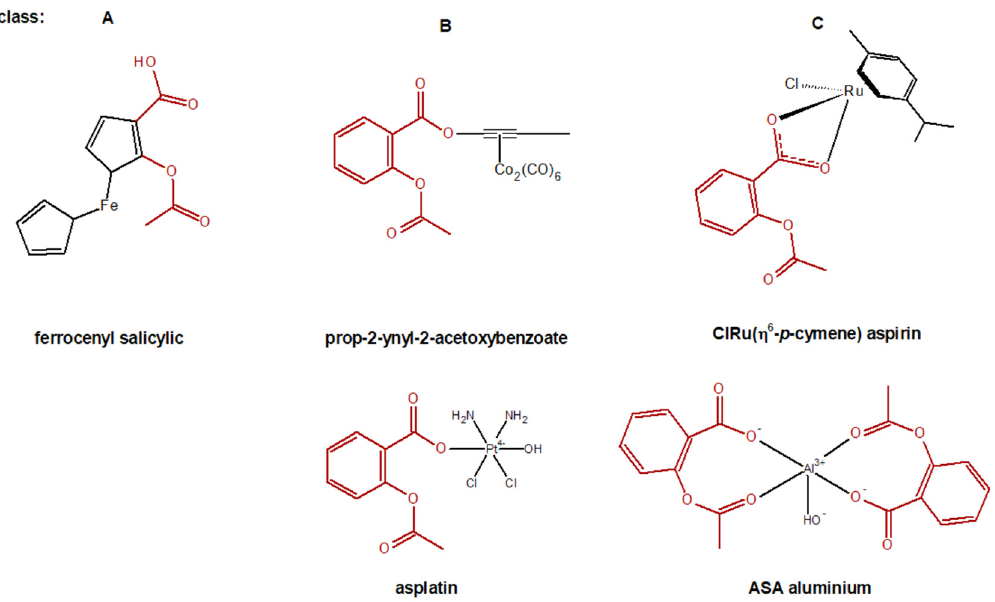
Figure 6. Selected chemical structures of general organometallic derivatives of ASA. Classification according to [236]. ASA moiety is marked in red.